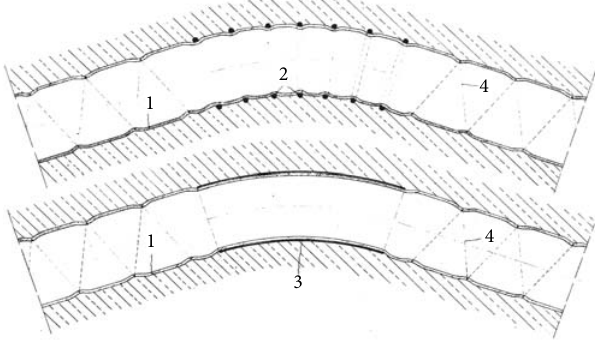
Figure 5: Concept drawing by Leonhardt for using inflated tubes as ribbed rubber hoses